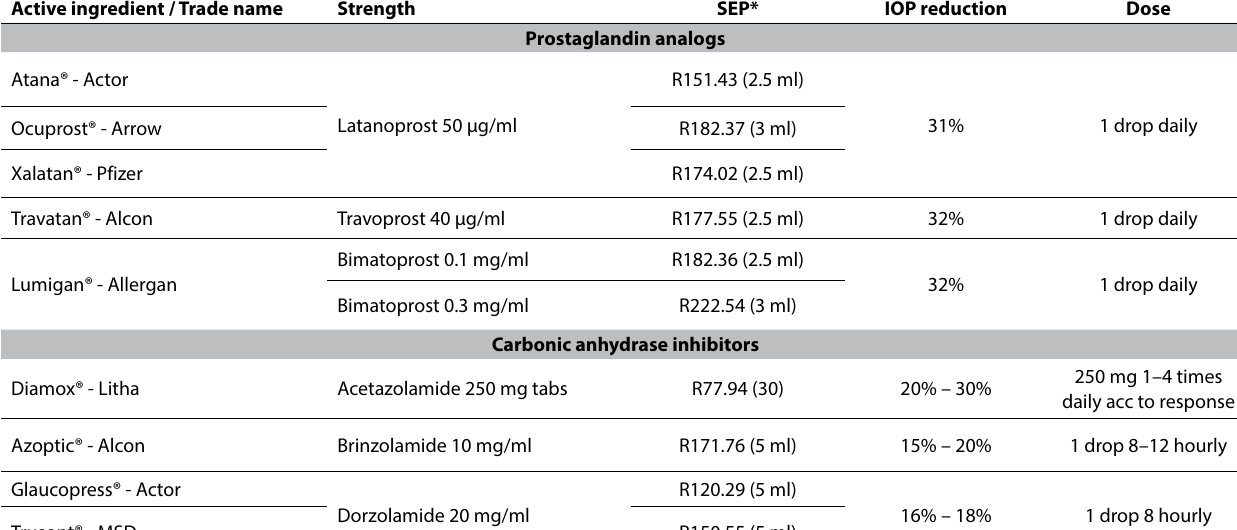
Table 2. Currently available drugs in the management of